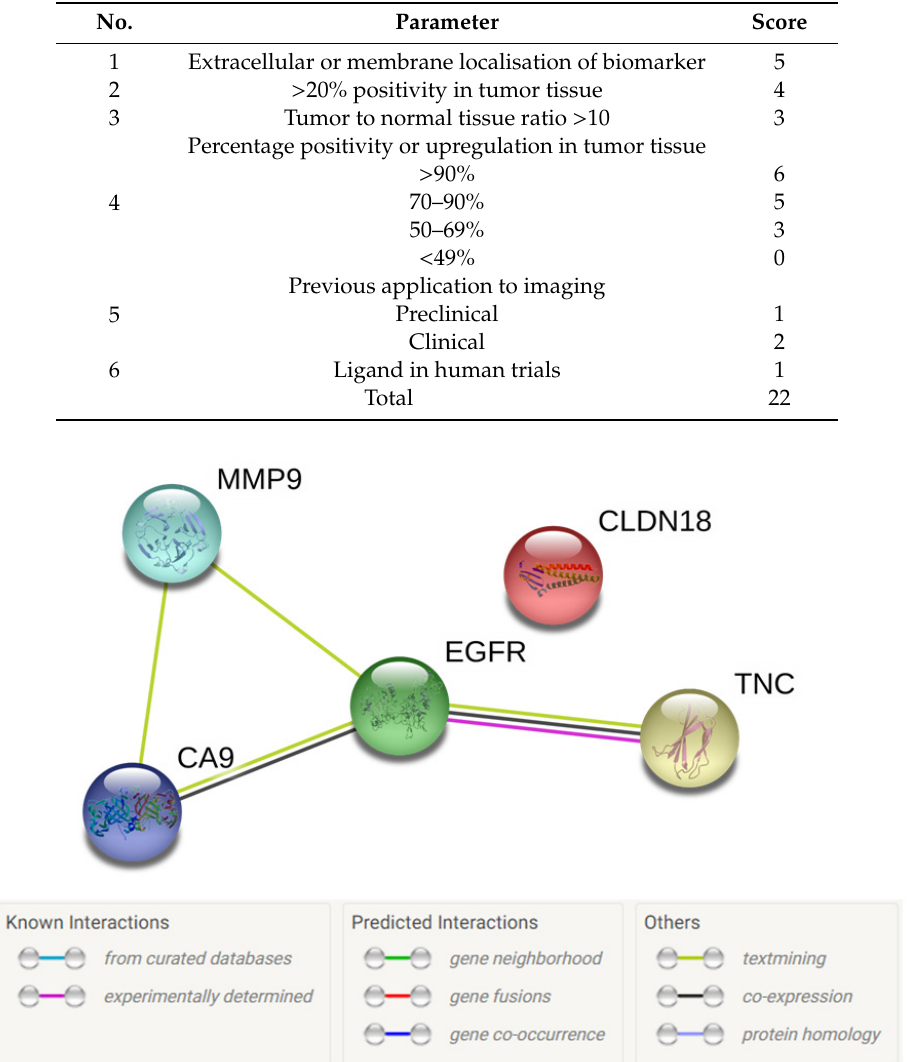
Figure 3. STRING network of the top five selected candidate biomarkers for theranosis in CCA. The green lines represent interaction between biomarkers as determined by text mining (automated, unsupervised search of PubMed for proteins mentioned together). This shows that there are associations between MMP9, CA9, and EGFR, as well as TNC and EGFR. The black line represents co-presence of biomarkers (CA9 and EGFR; TNC and EGFR). The pink line represents an experimentally determined association between TNC and EGFR. There are no known associations between CLDN18 and the other four selected candidate biomarkers.